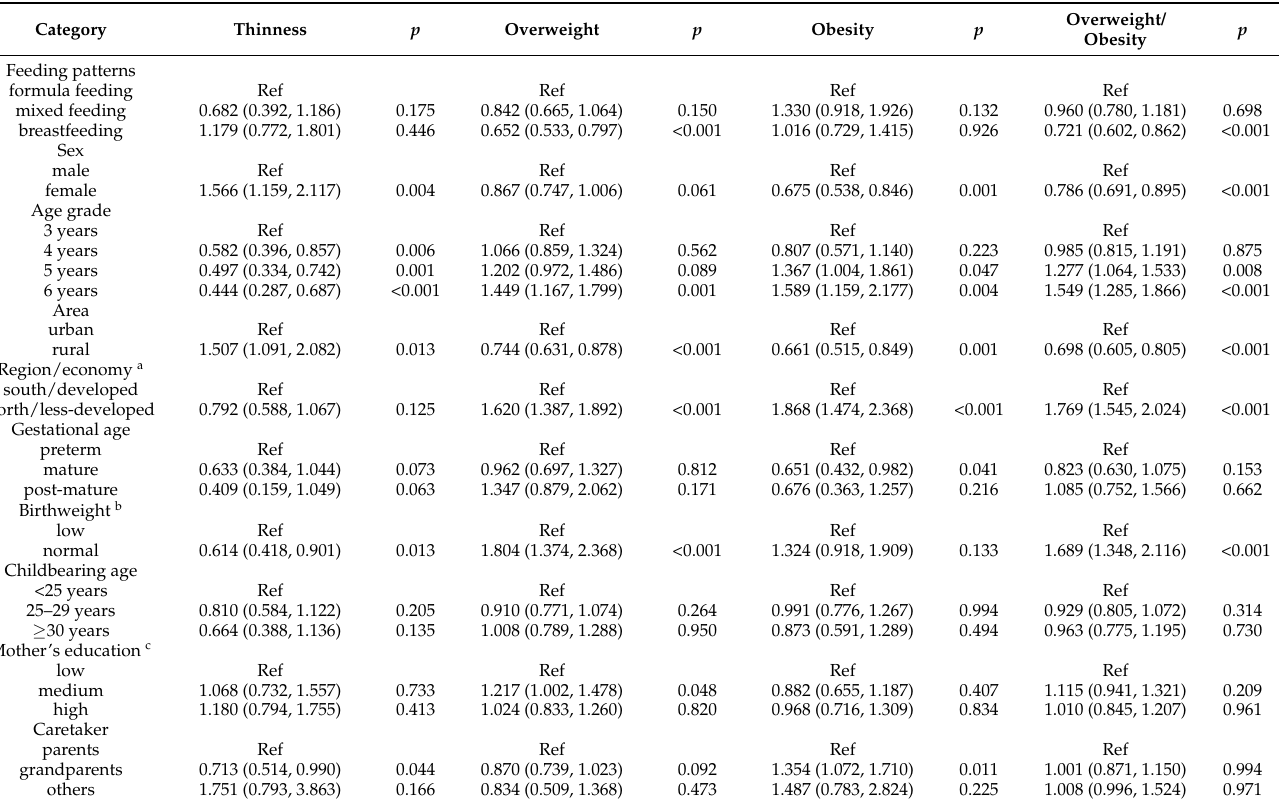
Table 2. Adjusted ORs (95% CI) for breastfeeding and covariates for thinness, overweight, and obesity in multivariate logistic regression models.